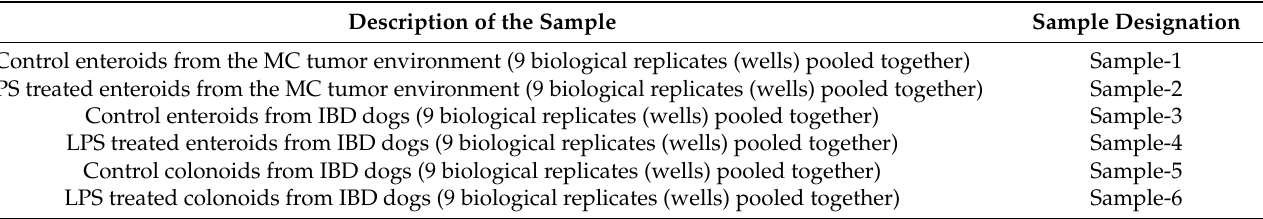
Table 2. A detailed description of the